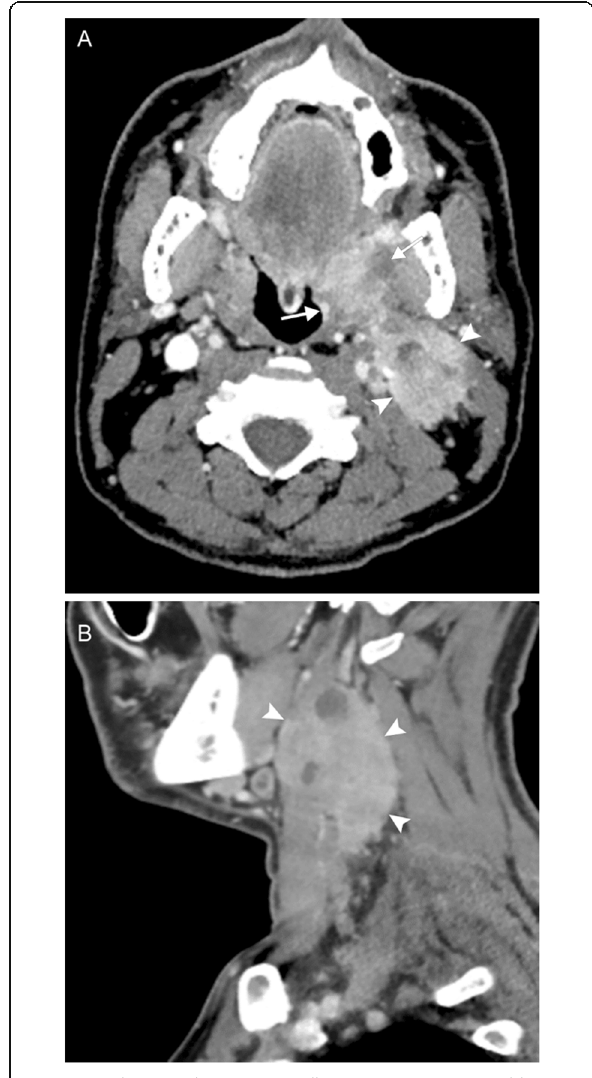
Fig. 7 Oropharyngeal squamous cell carcinoma. A 40-year-old man presenting with tender neck mass, dysphagia to solid food, odynophagia, and voice changes. Axial ( a ) and sagittal ( b ) contrast- enhanced CT images reveal an enhancing mass at the left oropharynx (arrows) and extensive left-sided lymphadenopathy, including a large level II nodal conglomerate with central areas of necrosis (arrowheads). Biopsy revealed this to be human papilloma virus (HPV)-mediated squamous cell carcinoma. Voice change was attributed to encroachment upon the carotid space resulting in vagal nerve irritation.